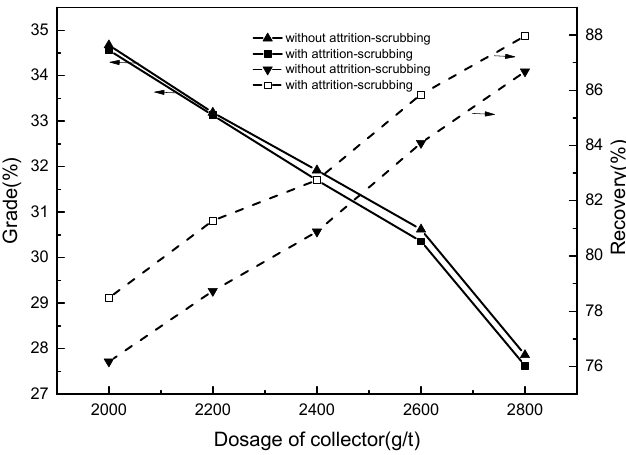
Figure 5. The results of the collector dosage on the flotation behaviors of ilmenite.